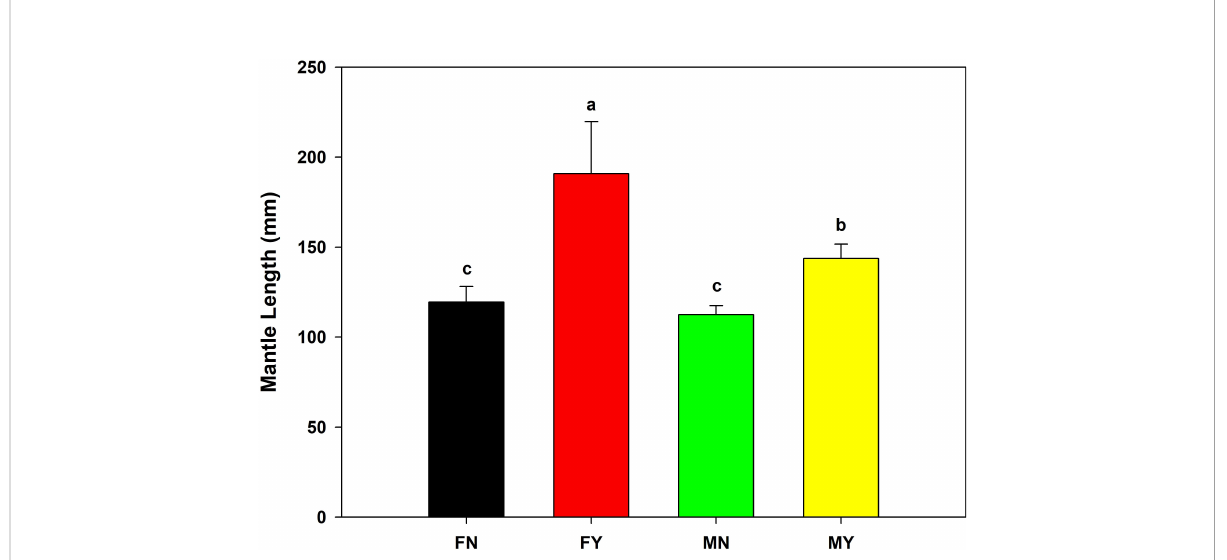
FIGURE 1 Mantle lengths of medium-form populations of Sthenoteuthis oualaniensis . Signi fi cant differences are indicated by different letters (p <